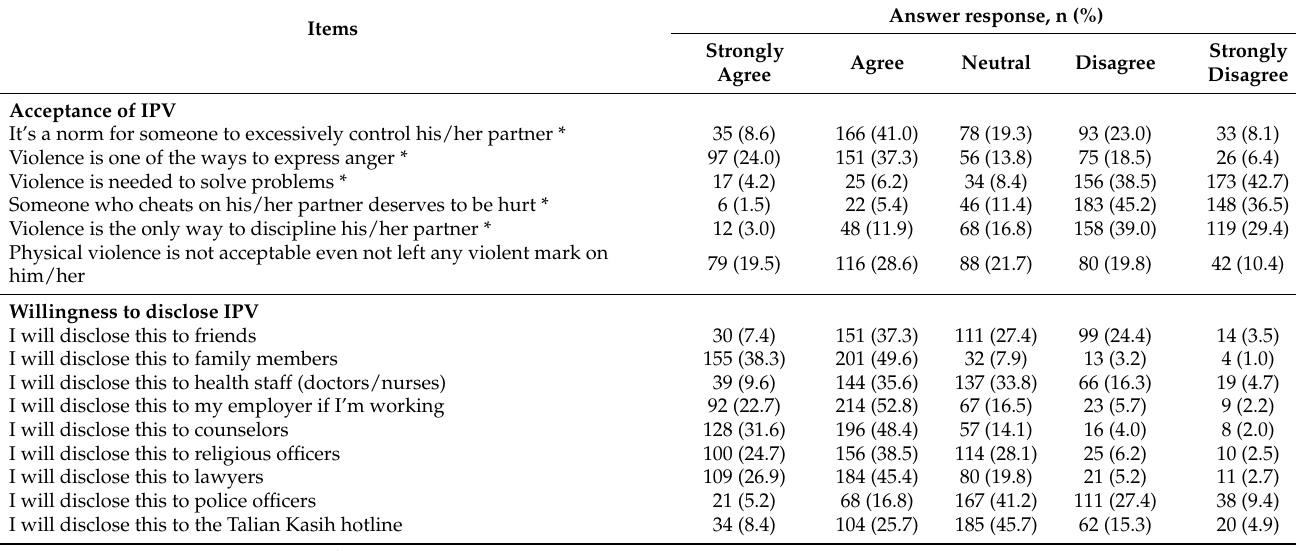
Table 2. Attitudes toward IPV domain in MY-PAIPVQ (n =